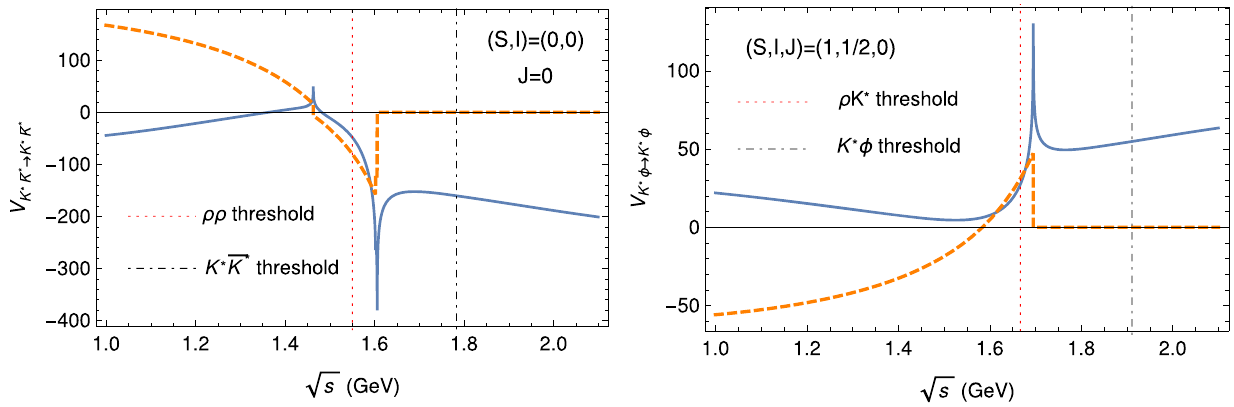
Fig. 2 S -wave potentials for K ∗ ¯ K ∗ → K ∗ ¯ K ∗ with ( S , I , J ) = ( 0 , 0 , 0 ) and K ∗ φ → K ∗ φ with ( S , I , J ) = ( 1 , 1 / 2 , 0 ) for our cal- culation (real part: solid curve, imaginary part: dashed curve). The